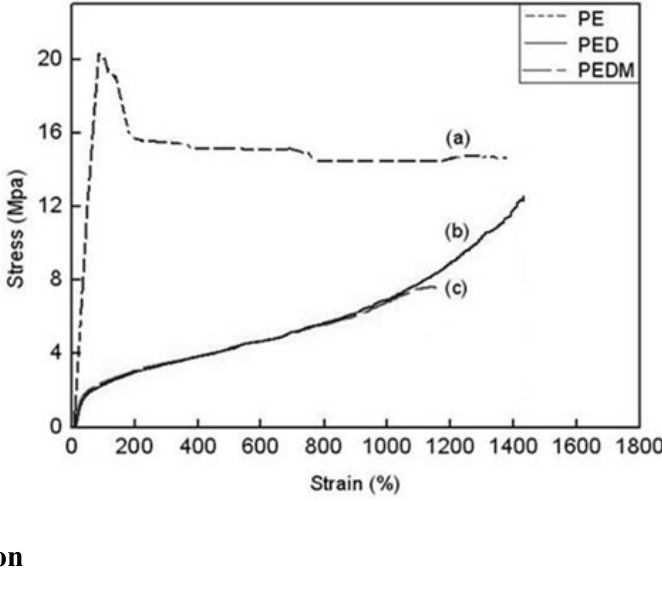
Figure 9. Stress and strain curves of ( a ) PE, ( b ) PED and ( c )